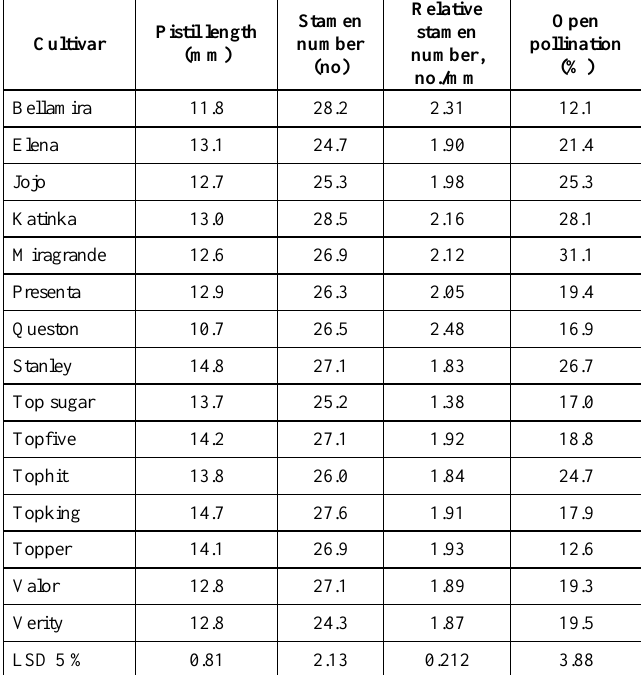
Table 2. Comparative studies of morphogenetical traits (2004-2007)